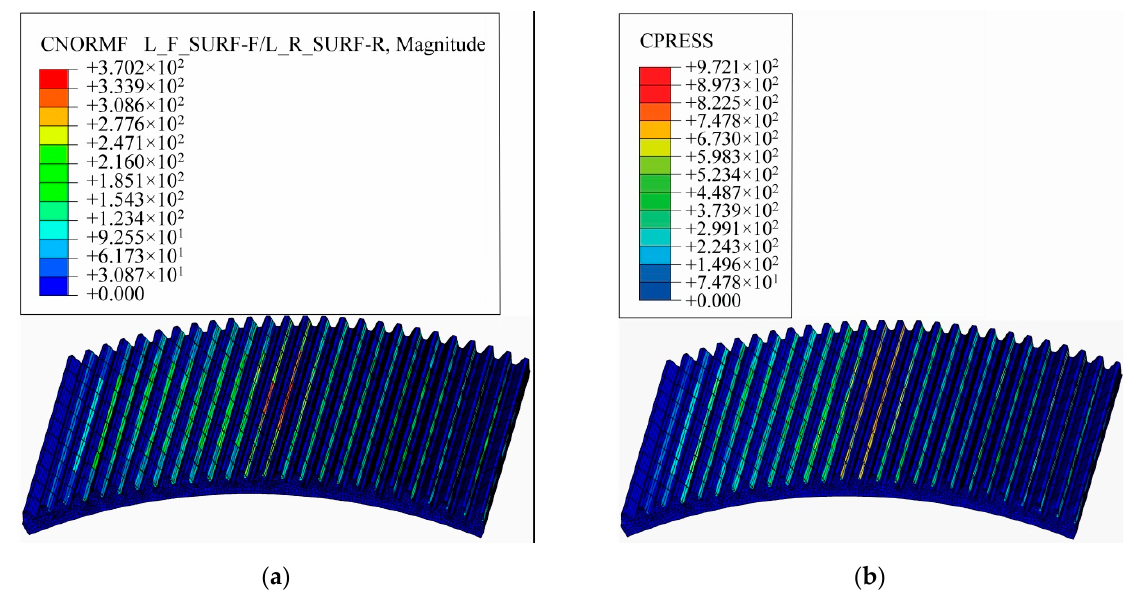
Figure 18. ( a ) The normal contact force of the disposable flexible wheel under full load; ( b ) the contact stresses of the disposable flexible wheel under full load.